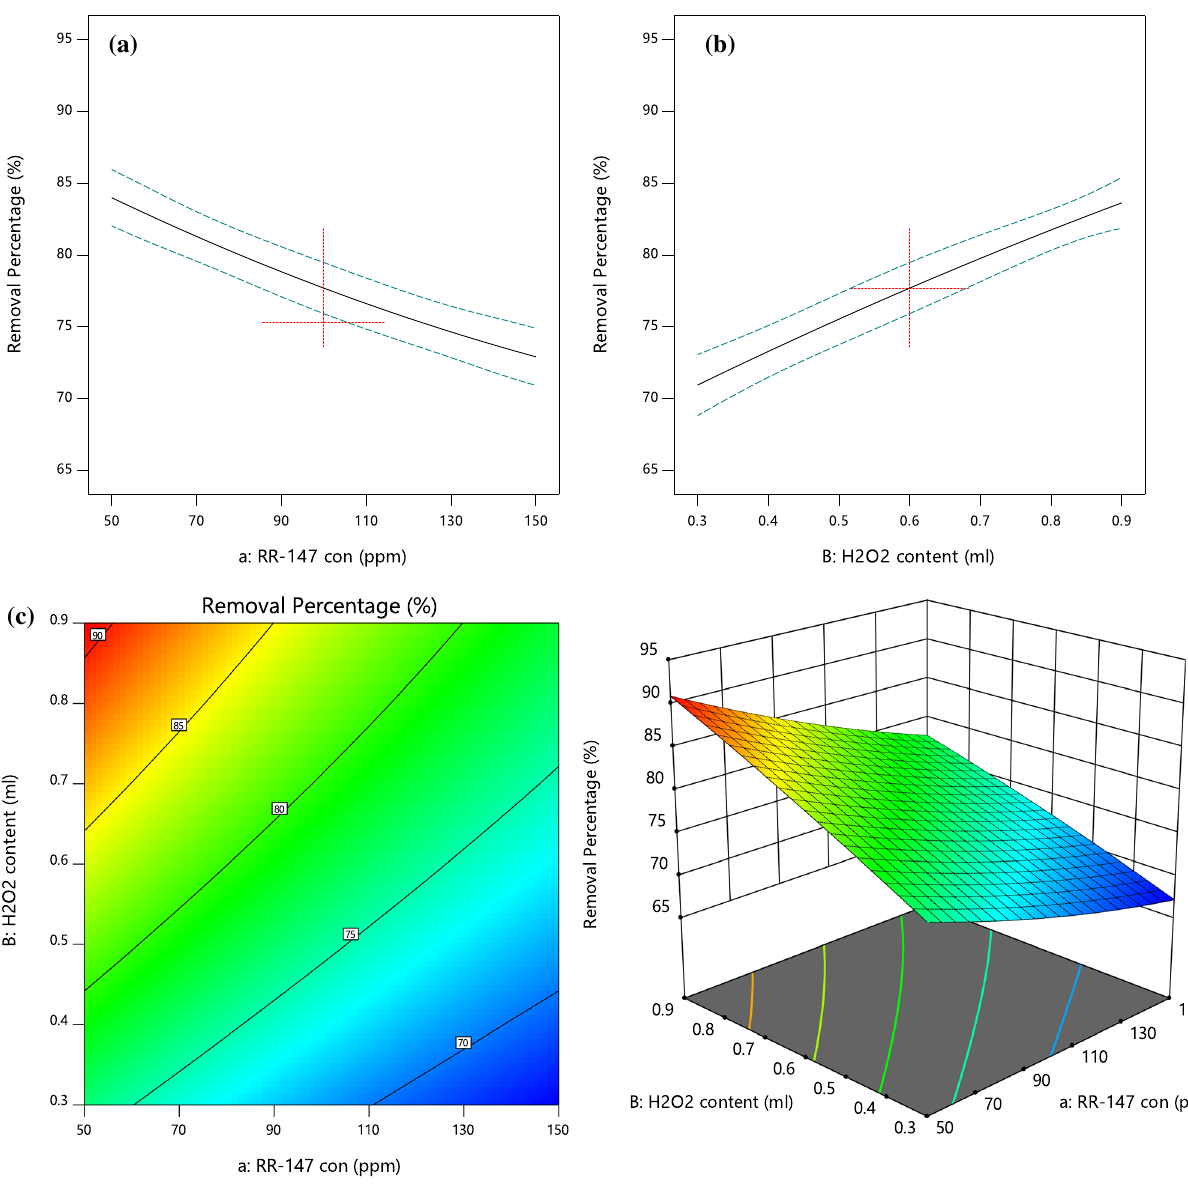
Fig. 7 Influence of various dye concentration a with different H plot according to RSM